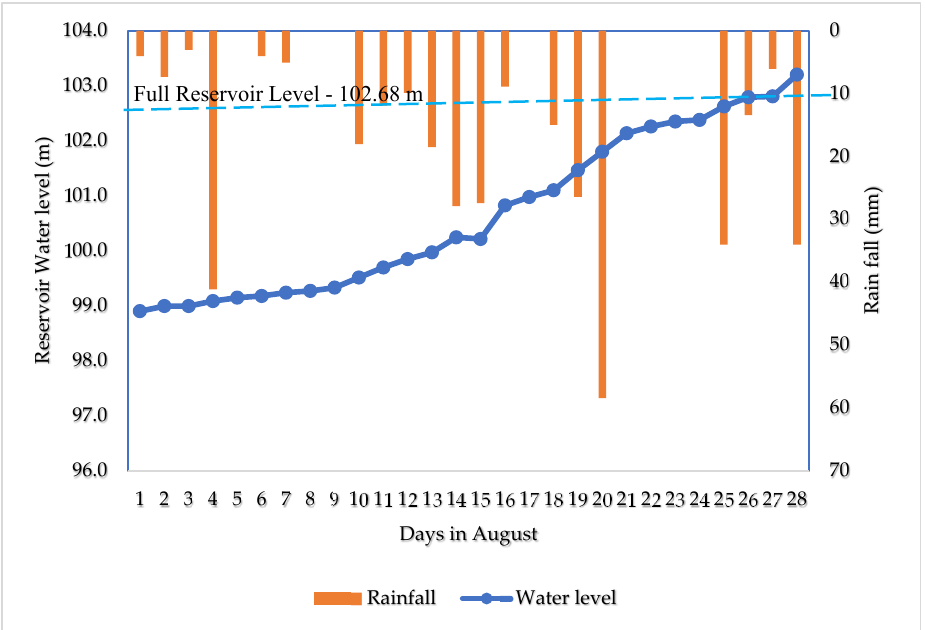
Figure 3. Reservoir water level and rainfall condition of Swa Dam before the breach event (1–28 August 2018) (record by the IWUMD).